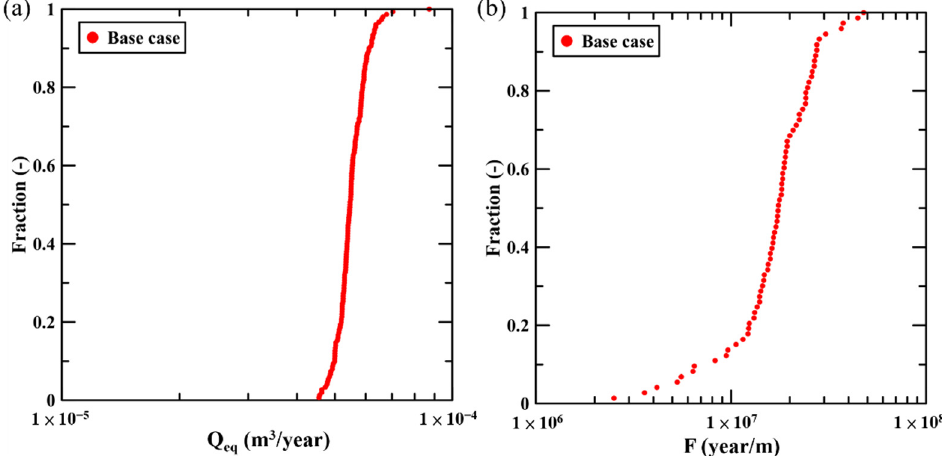
Figure 10. Q eq and F for the Q1 path in the base case. ( a ) The Q eq for the Q1 path of the base case; ( b ) The F for the Q1 path of the base